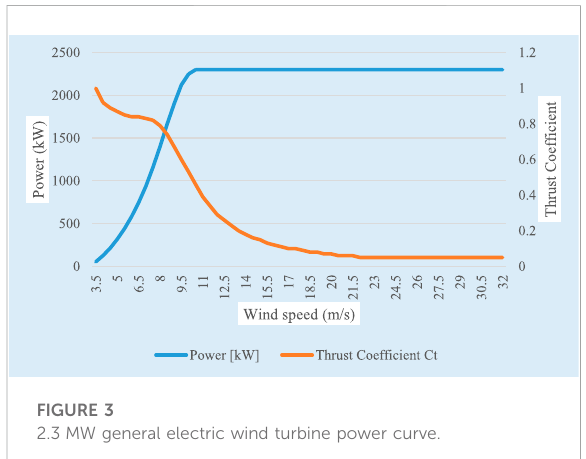
FIGURE 3 2.3 MW general electric wind turbine power